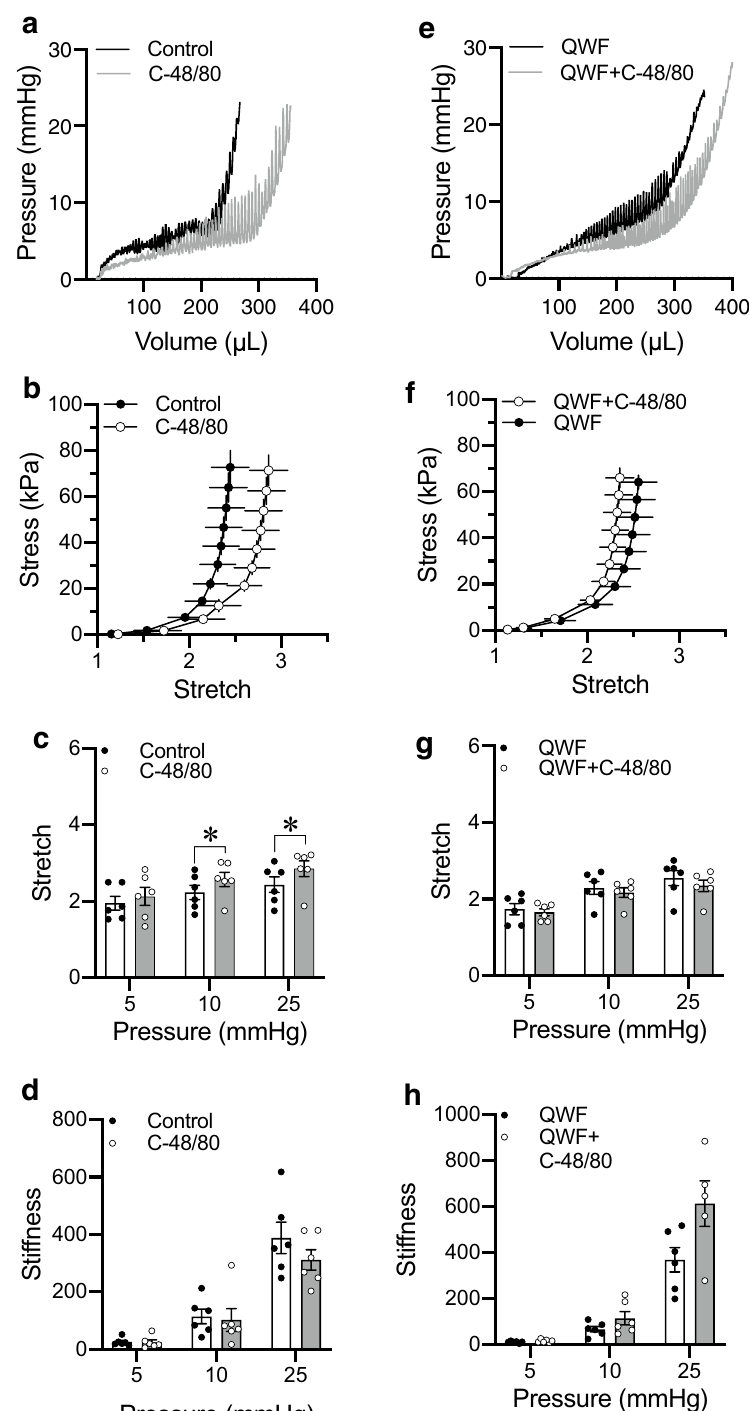
Figure 3. Compound 48/80 increases bladder wall compliance through Mrgprb2 activation. ( a ) Representative pressure–volume trace of ex vivo filling of C57Bl/6 mouse bladders in the absence and presence of the Mrgprb2 agonist Compound 48/80 alone (10 µg/mL). ( e ) representative pressure–volume trace after prior exposure to the Mrgprb2 antagonist QWF (10 µM). ( b , c ) compliance is increased in the presence of C-48/80 (N = 6) signified by the rightward shift of the stress-stretch curve and a significant increase in stretch at 10 ( P = 0.011 vehicle vs. C-48/80) and 25 mmHg ( P = 0.01 vehicle vs. C-48/80). ( f , g ) the increase in compliance by C-48/80 is blocked by QWF (N = 6) signified by the absence of rightward shift of the stress-stretch curve and increase in stretch ( P = 0.4, P = 0.14 and P = 0.07 for 5, 10 and 25 mmHg respectively; QWF vs. QWF + C-48/80). ( d , h ) Stiffness is unchanged in both groups. Within the group comparisons were made via two-tailed, paired Student’s t-test. “C-48/80”: 10 µg/mL Compound 48/80; “QWF”: 10 µM